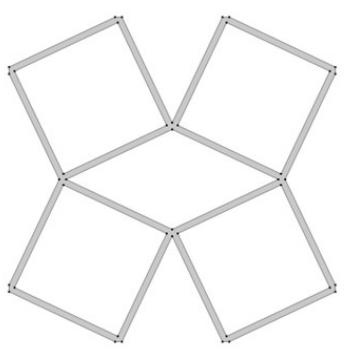
Figure 6. The obtained unit cell for w 1 = 0.15.